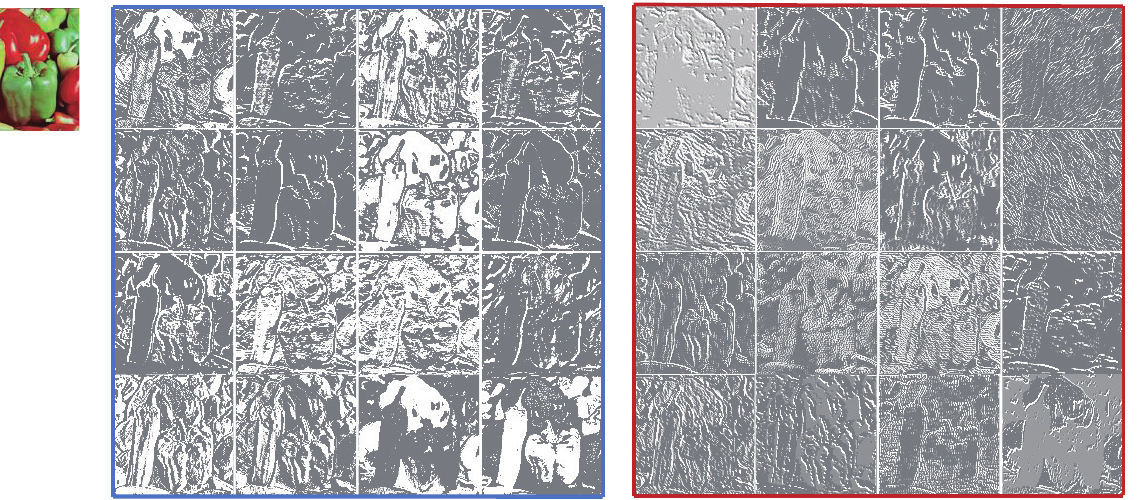
Figure 8. Visualization of the feature map generated by the first EFGB in the first